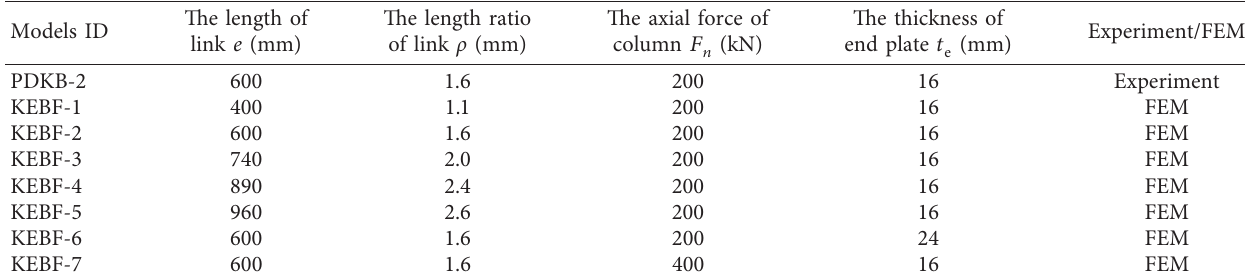
Table 15: The finite element analysis model